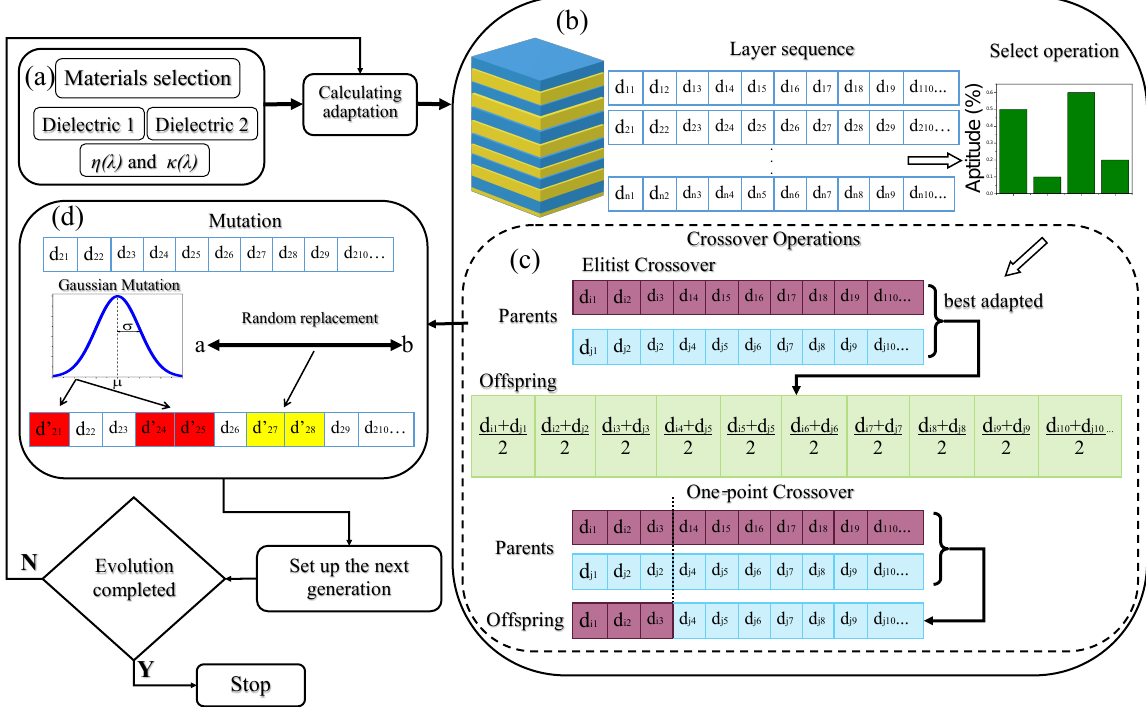
Figure 2. Overview of the GA used to optimize the reflectance spectrum of a one-dimensional photonic crystal. ( a ) A pair of different dielectric materials and their optical constants are chosen from the local database to generate a set of chromosomes randomly. These individuals will go through ( b ) selection, ( c ) crossing-over, and ( d ) mutation rounds to discover individuals capable of producing a specific optical